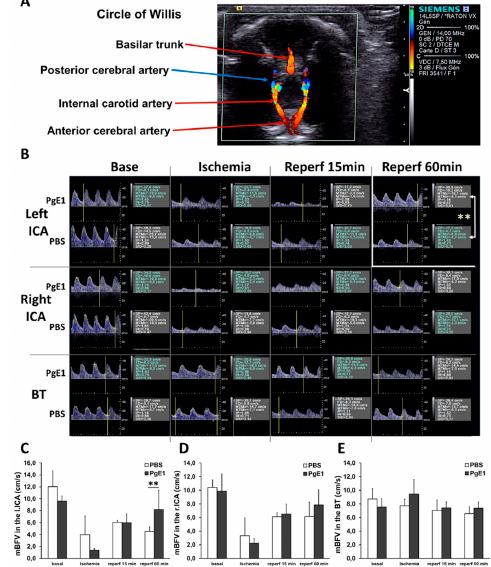
Figure 2. Blood-flow redistribution in the three great arteries of the circle of Willis after ischemia-reperfusion in P7 rats treated with PBS ( n = 6) and/or prostaglandin E1 (PgE1) ( n = 6). ( A ) Horizontal ultrasound cross-sectional imaging at the basis of the skull with color-Doppler mode showing the circle of Willis. The basilar trunk (BT) is revealed back, both intracranial internal carotid (ICA) and anterior cerebral arteries are revealed in red color at the front. The first branches of the ICAs, the posterior cerebral arteries are revealed in blue color (opposite flow-direction than in ICAs and BT). ( B ) After localization of the arteries, a pulsed-Doppler sample can be positioned on the different arteries for Doppler velocity waveforms recordings at the different steps of the protocol. (SP: systolic peak velocity; FD: end-diastolic velocity; MTMx: mean time maximal velocity; MTMn: mean time mean velocity; IP: index of pulsatility; IR: index of resistance; S/D systolic peak velocity/end-diastolic velocity. ( C , D ) is the mean blood flow velocities (mBFV) in the left and right ICAs decreased during ischemia; mBFVs recorded at 60 min of reperfusion remained lower than that measured in basal conditions in PBS-treated animals. In contrast, mBFVs returned to basal values in PgE1-treated rat pups (** p = 0.006, PgE1 vs. PBS). ( E ) mBFVs recorded in the BT showing no difference between PBS- and PgE1-treated animals. ** p < 0.01 PBS vs. PgE1.